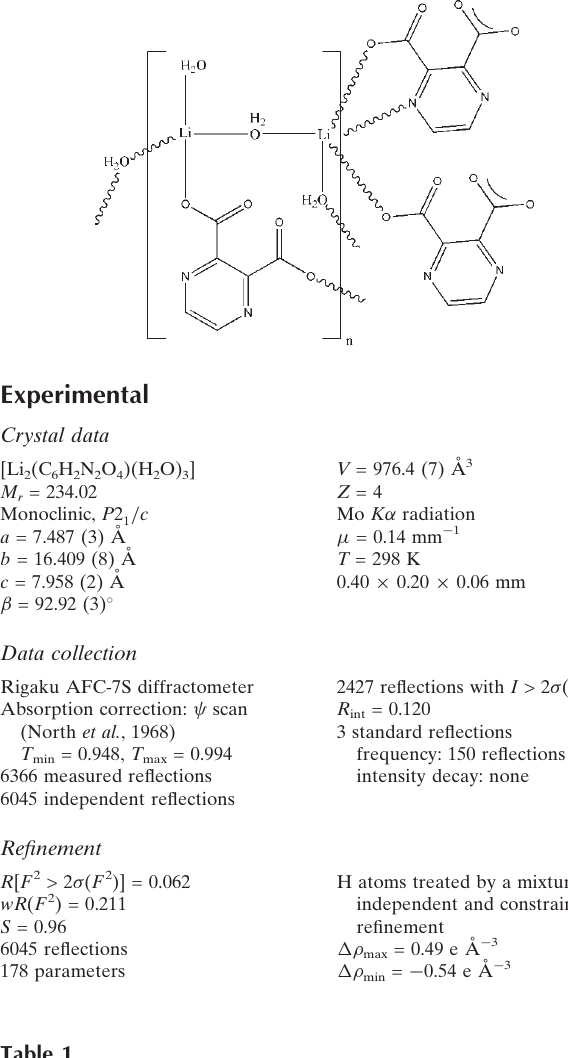
Selected bond lengths (A˚ ).